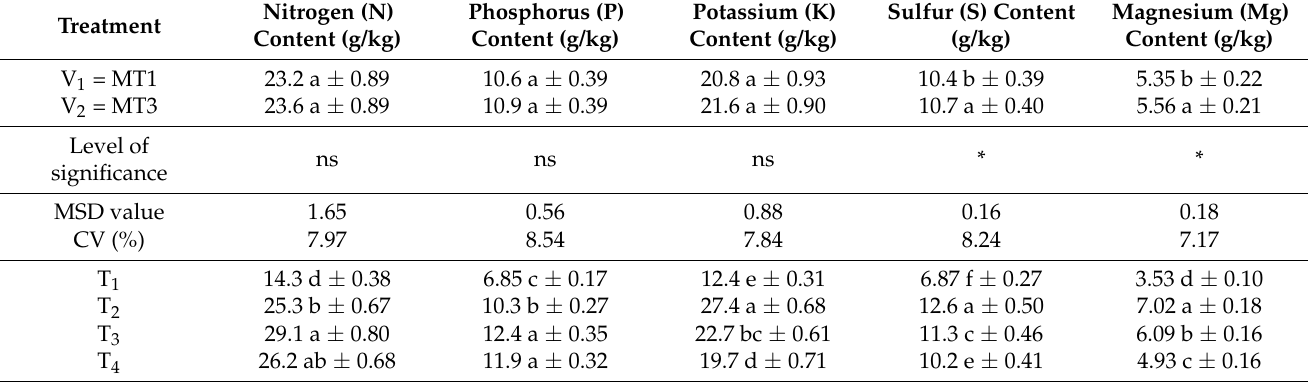
Table 7. Effect of zinc fertilizer and zinc oxide nanoparticles on nitrogen, phosphorus, potassium, sulfur, and magnesium content in leaves of two selected tomato